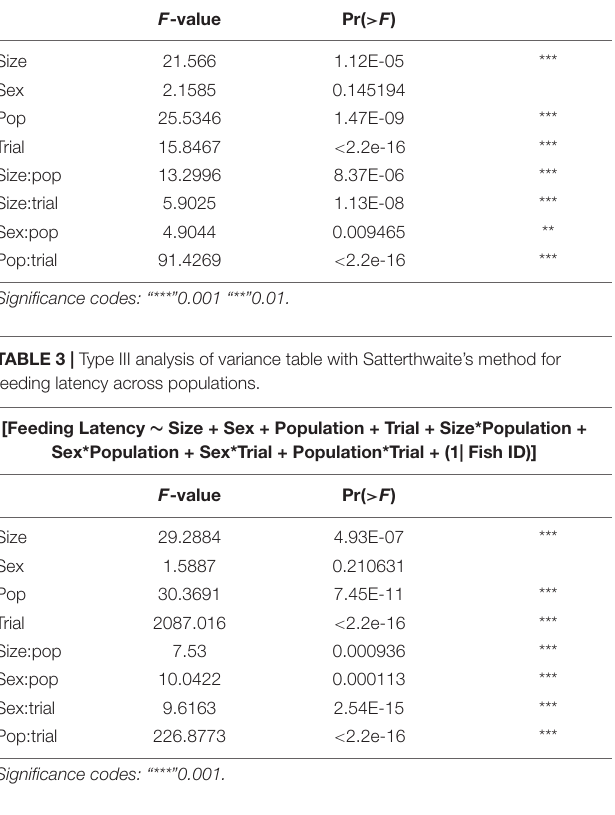
TABLE 2 | Type III analysis of variance table with Satterthwaite’s method for exploration latency across populations.